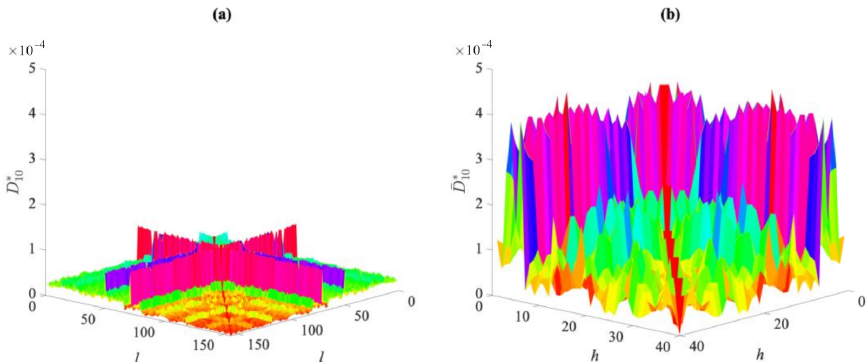
Figure 11. Z24 Bridge, p = 20: comparison between the distance values in matrices ( a ) D ∗ normal condition, and ( b )